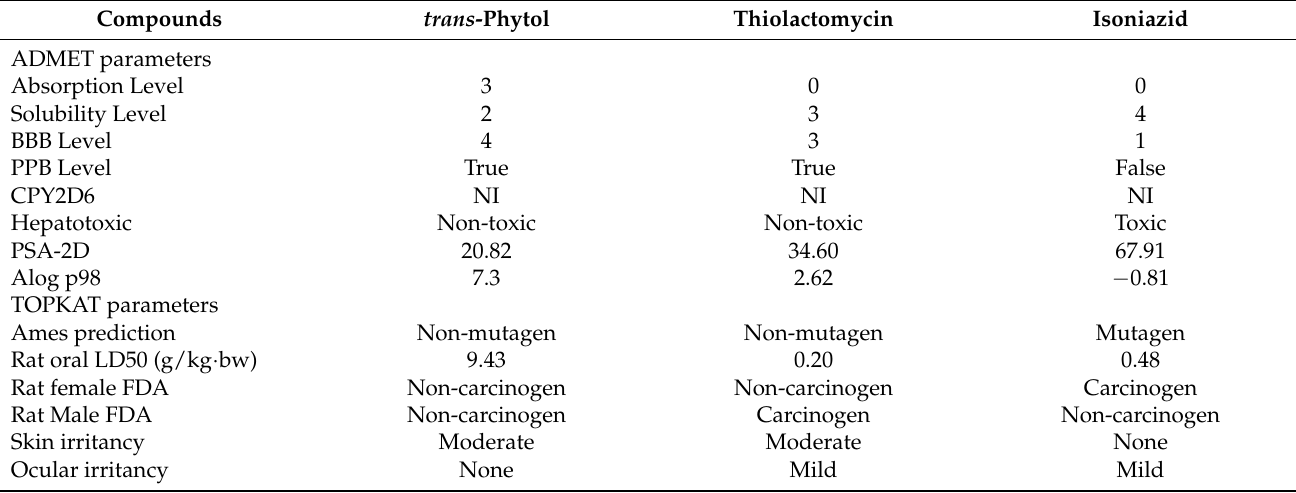
Table 4. The absorption, distribution, metabolism, excretion, and toxicity (ADME/TOPKAT) predictions for bioactive compound identified from the n -hexane fraction of Premna odorata leaves, trans -phytol, thiolactomycin (co-crystallized ligand) and isoniazid.